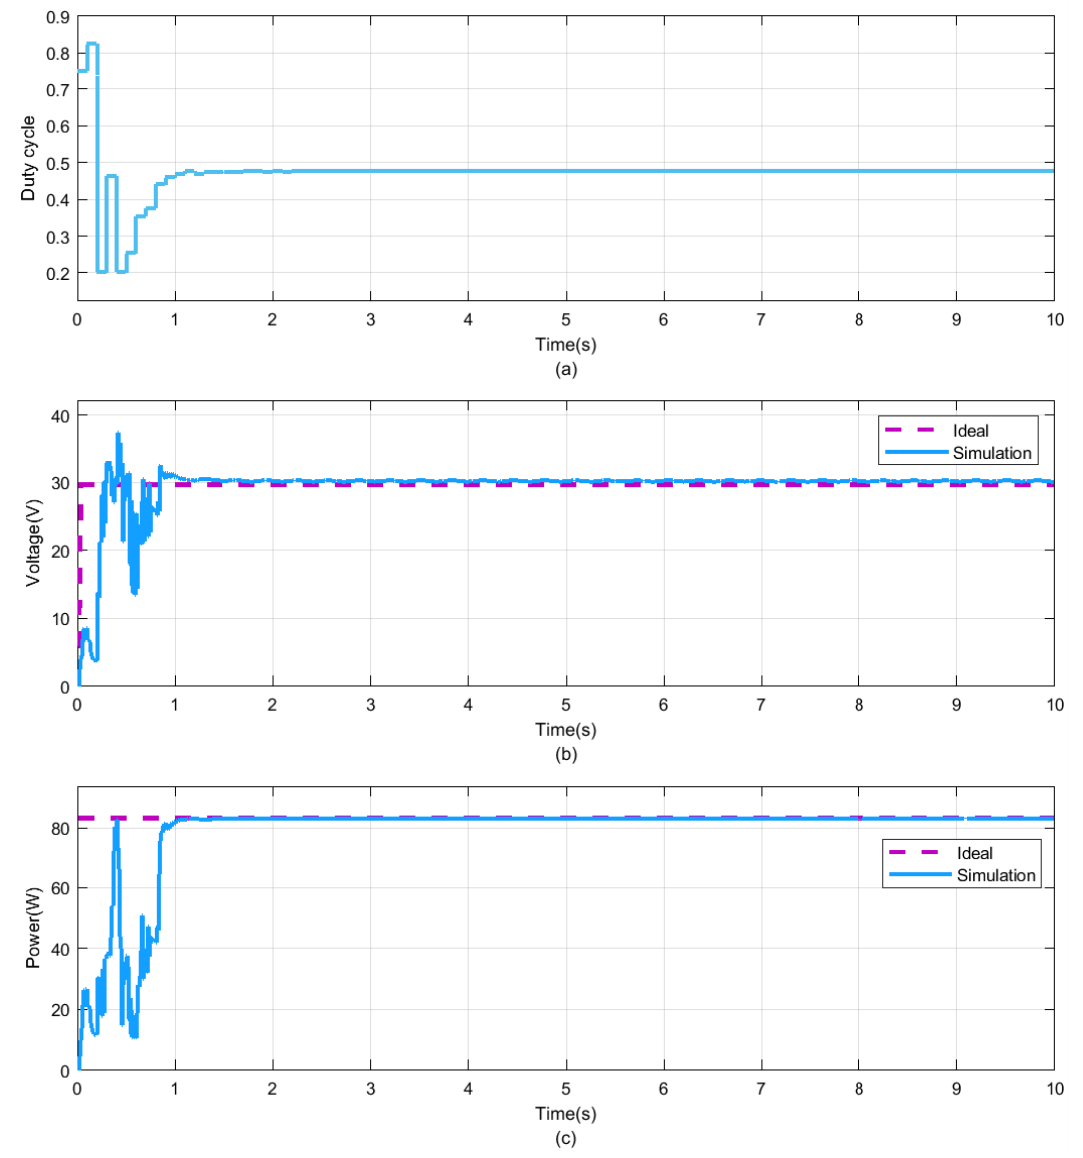
Figure 5. Simulation results under G = 800 W/m 2 , Tc = 48 ◦ C and Np = 2 given by the Improved Particle Swarm Optimisation (IPSO) algorithm: ( a ) Duty cycle, ( b ) Voltage, and ( c )